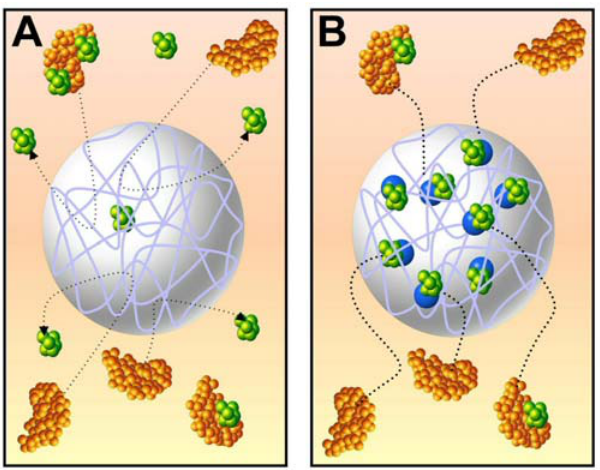
Figure 1. Sequestered low molecular weight species can diffuse out of underivatized hydrogel particles ( A ); Incorporation of affinity bait within the particle matrix enables the particle to effectively retain the harvested low molecular weight species and prevent them from escaping the particle matrix ( B